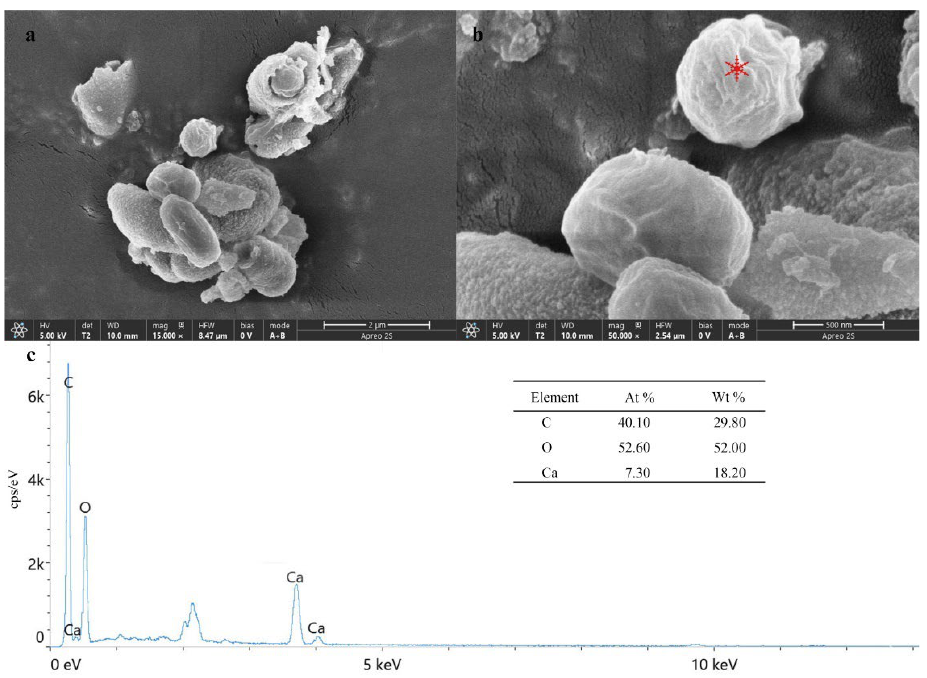
Figure 3. Morphological characteristics in SEM ( a , b ) and elemental composition analysis of BV by EDS ( c ).